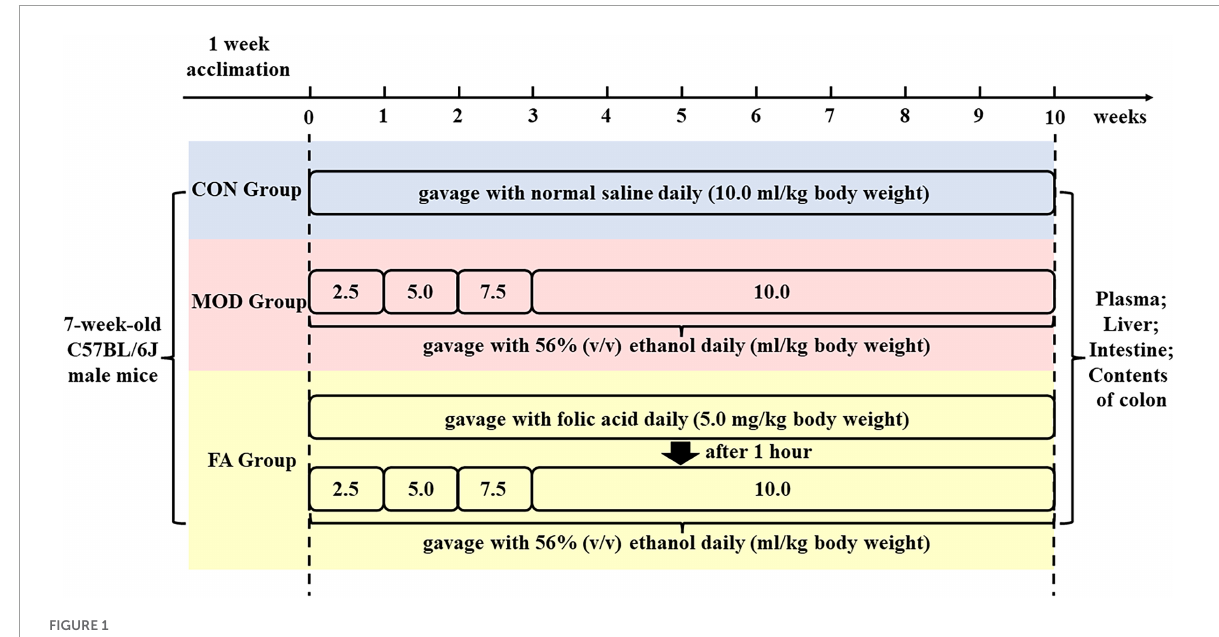
FIGURE1 Schedule of the experimental protocol and drug administration of folic acid and